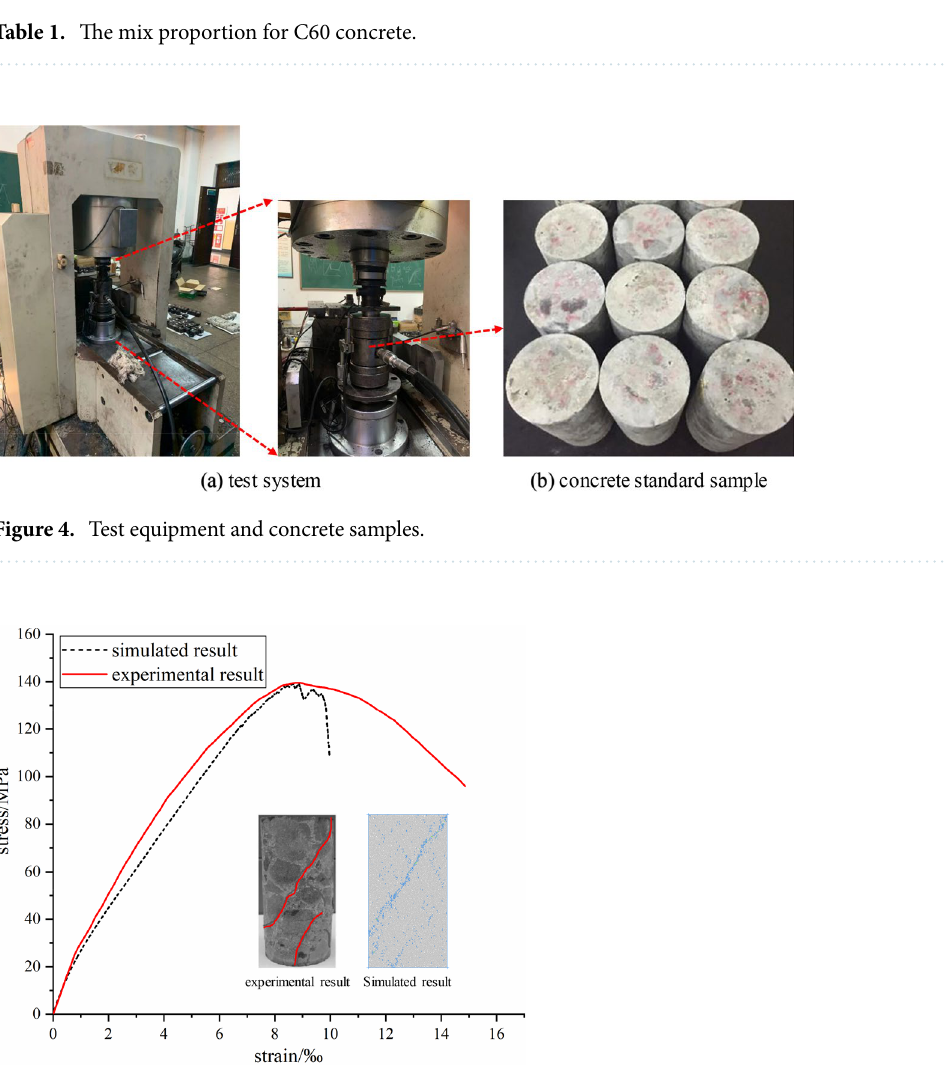
Figure 5. The stress–strain curve of numerical simulation and